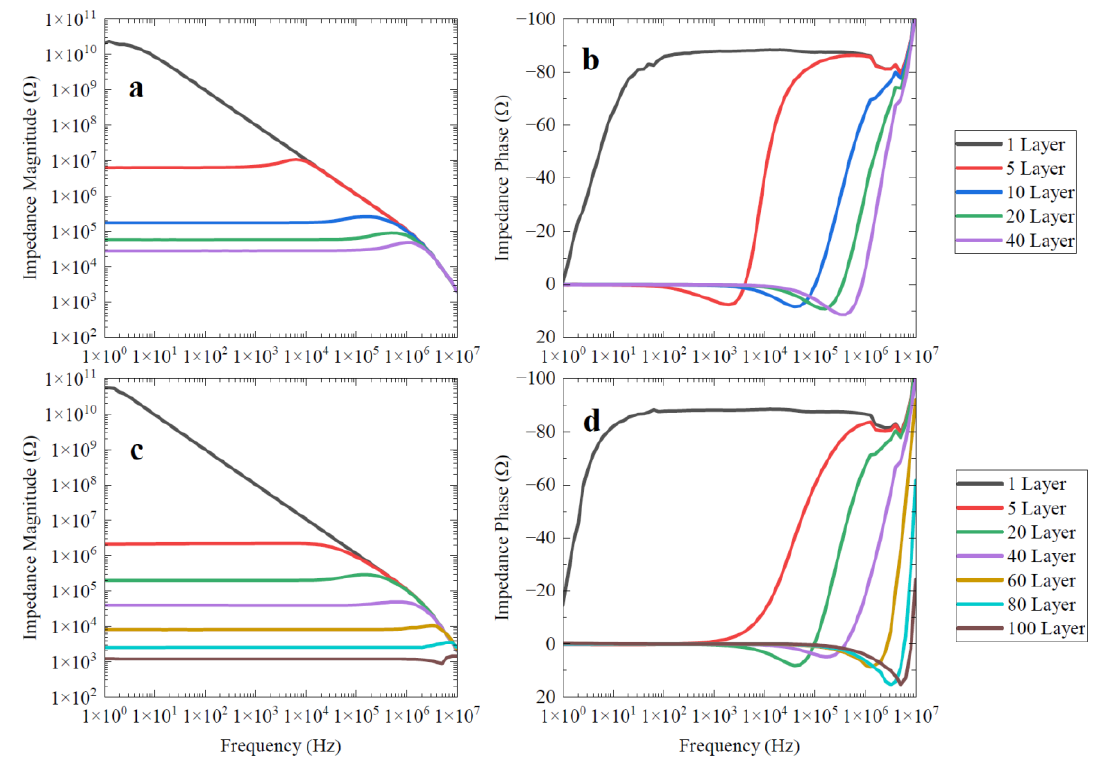
Figure 21. Electrical impedance spectroscopy for spin-coated samples (magnitude in ( a ) and phase in ( b )) and inkjet-printed samples (magnitude in ( c ) and phase in ( d )).